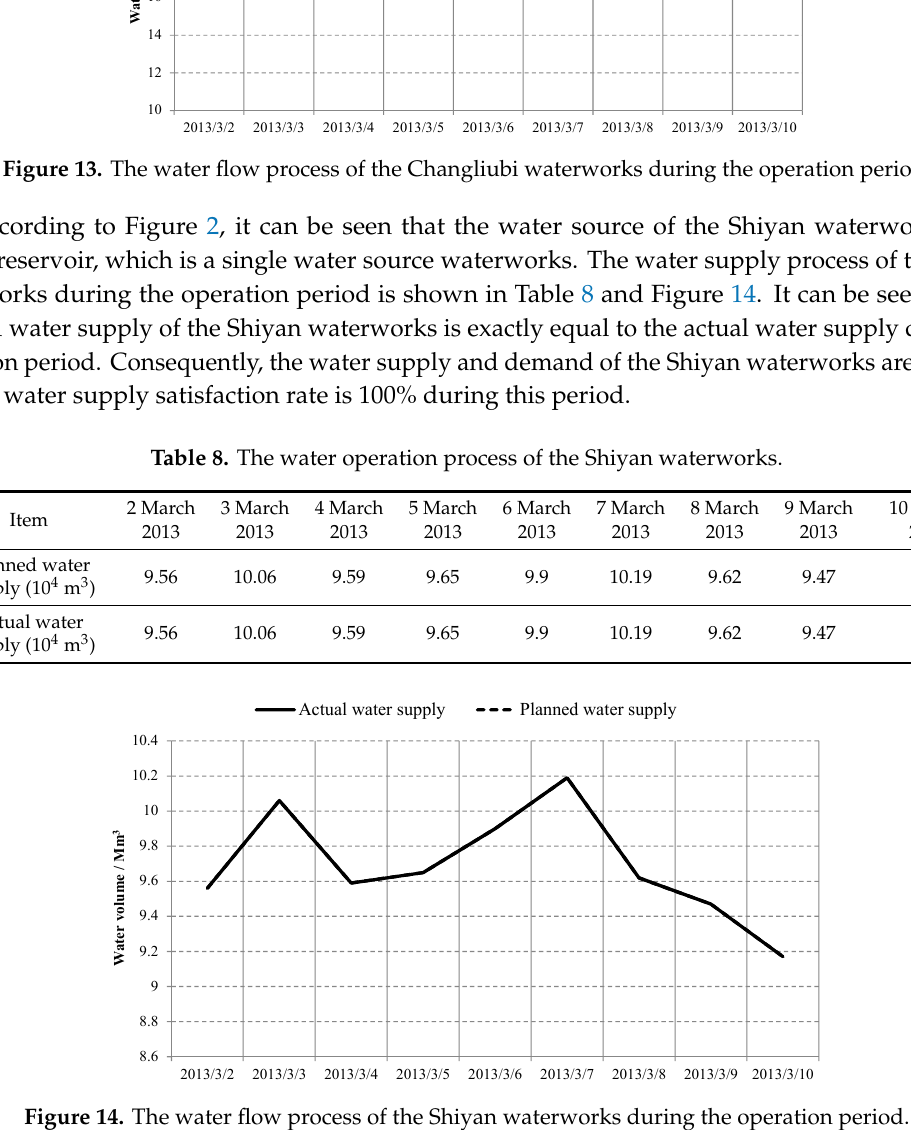
Table 9. The statistical values of the water demand satisfaction rate of waterworks for each subsystem.